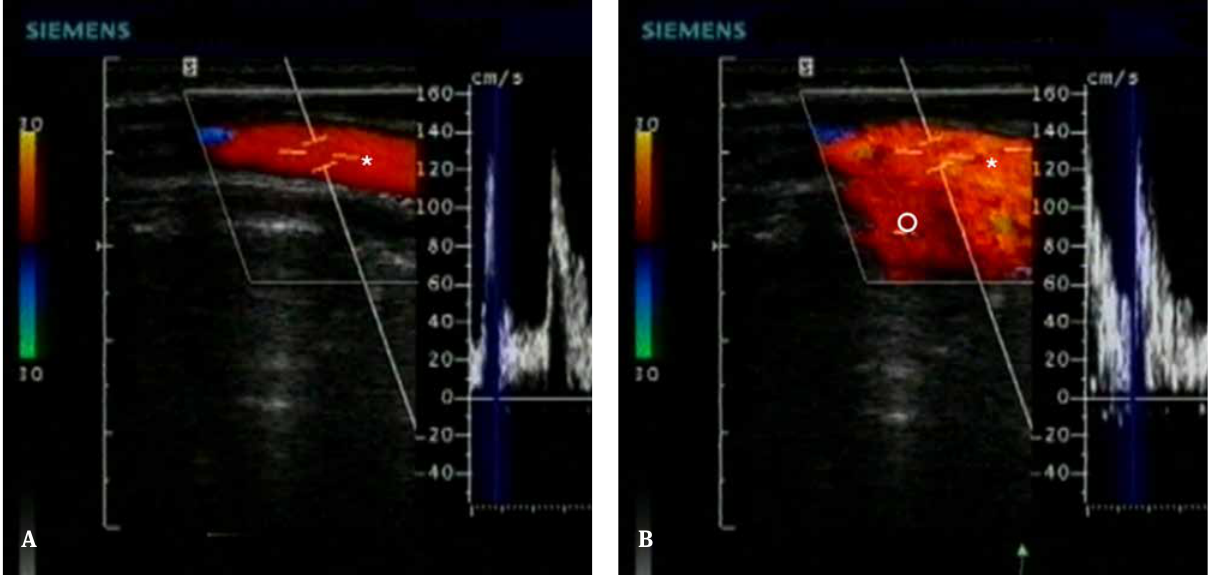
Figure 1 a-b: Pulmonary arteriovenous malformation on CE-US B-mode, color flow and pulsed-waved Doppler of the left common carotid artery (circle) of a patient with a PAVM is demonstrated before (a) and after (b) contrast injection.